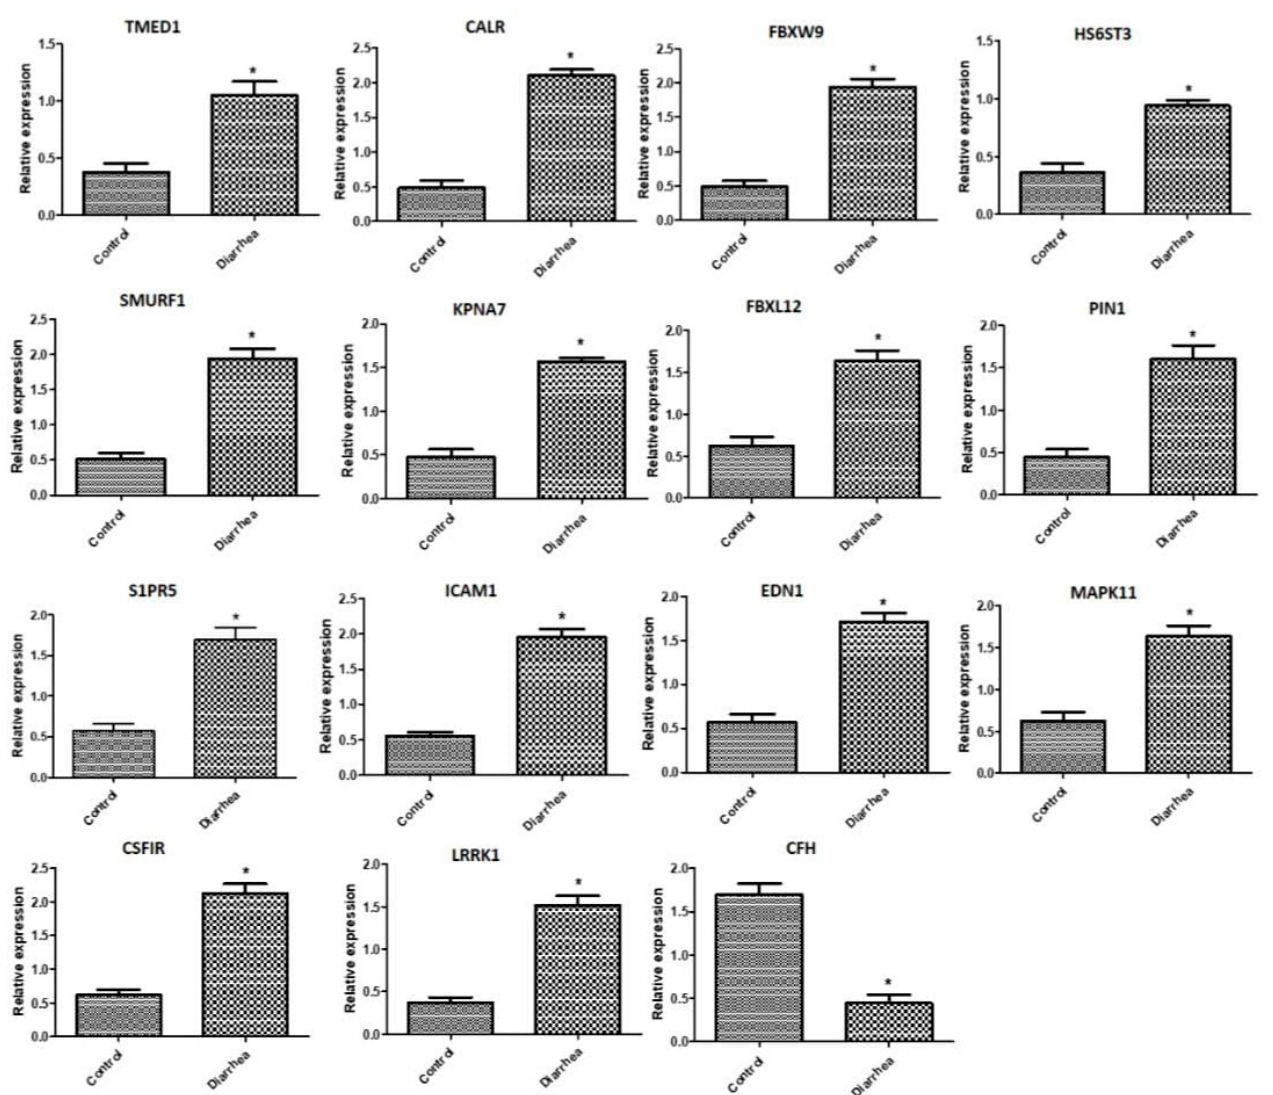
Figure 1. Comparative expression patterns of the genes TMED1 , CALR , FBXW9 , HS6ST3 , SMURF1 , KPNA7 , FBXL2 , PIN1 , S1PR5 , ICAM1 , EDN1 , MAPK11 , CSF1R , LRRK1 , and CFH in healthy and diarrhea affected Baladi kids. * means significance when p < 0.05.